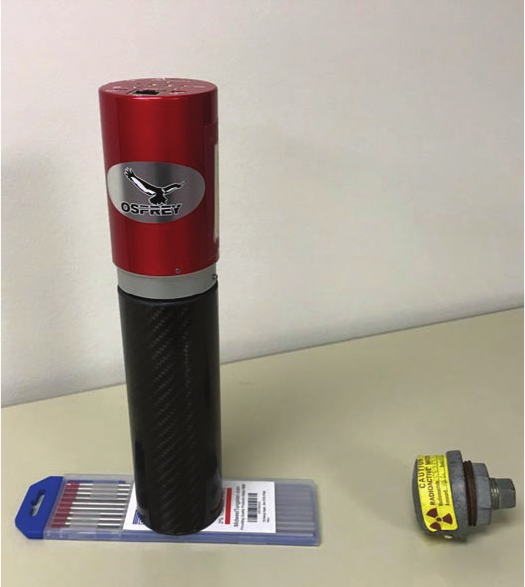
Figure 6 Test geometry used for these initial set of tests. Thoriated tungsten welding rods under detector and Cs- 137